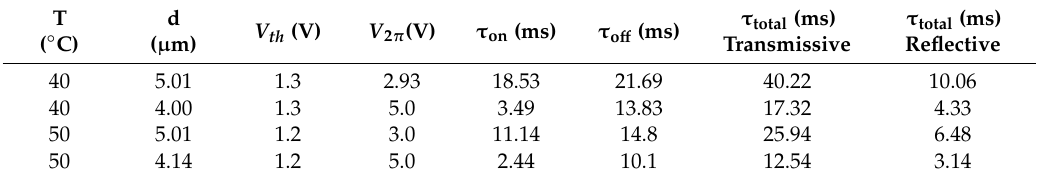
Table 4. Measured response time of a transmissive UCF-216 cell with d = 5.01 µ m, and the extrapolated response time to the corresponding reflective cells at 40 ◦ C and 50 ◦ C. λ = 633